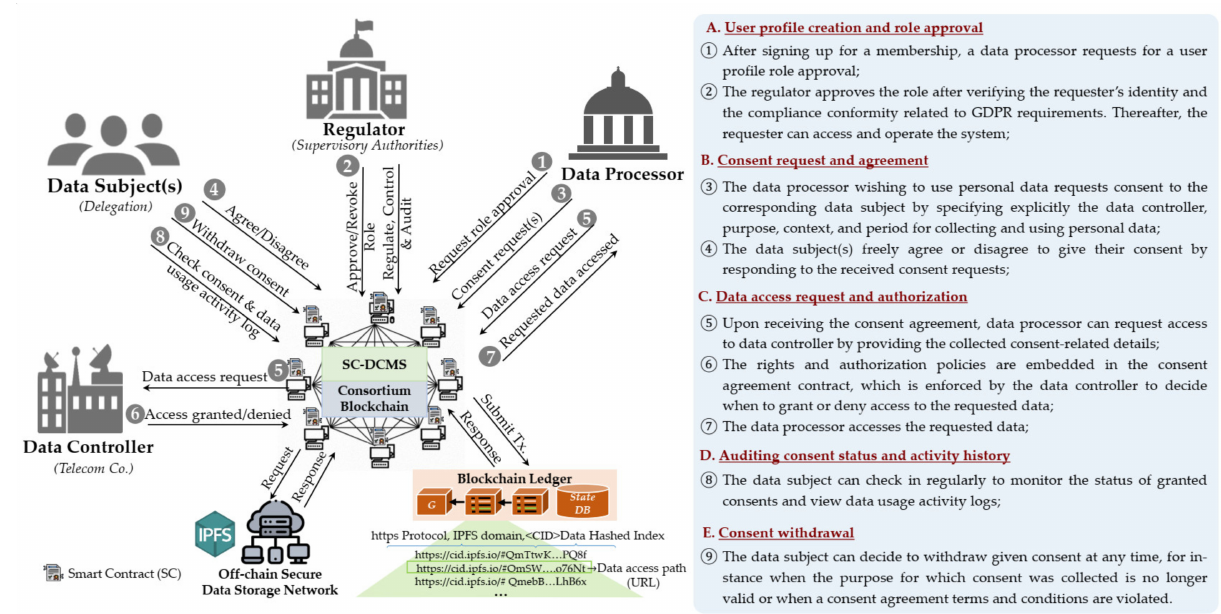
Figure 2. Use cases of the proposed smart-contract-based dynamic consent management system (SC-DCMS) for collecting and using personal data under